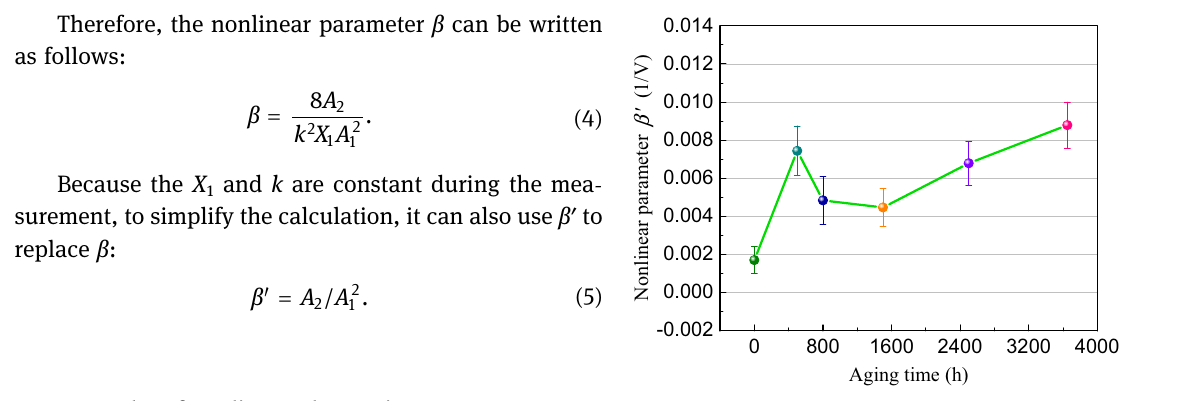
Figure 6: The change of the nonlinear parameter β ′ in TP347HFG during the